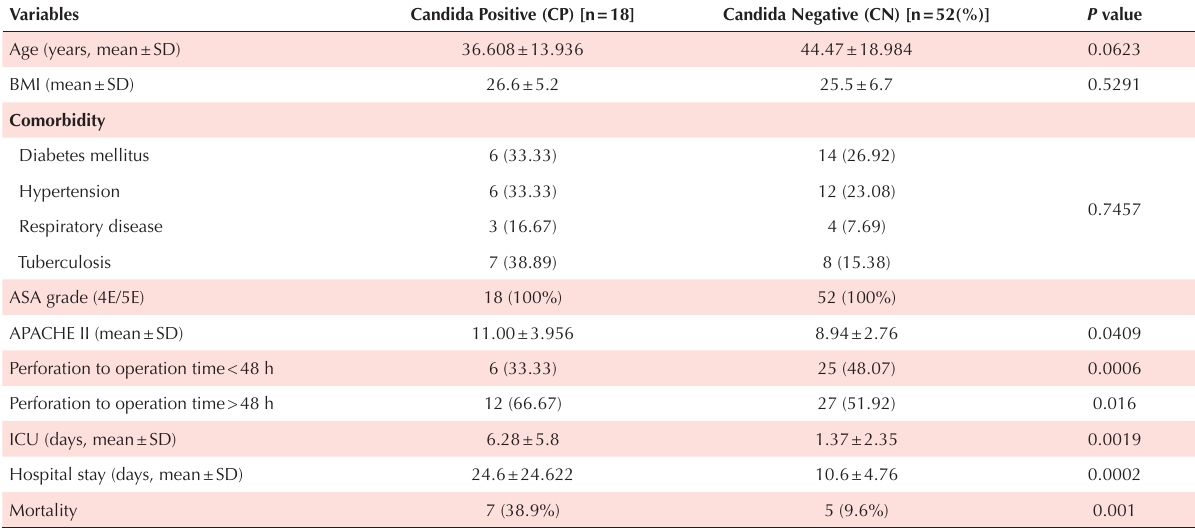
Table 2. Patient demographics and postoperative complications Variables